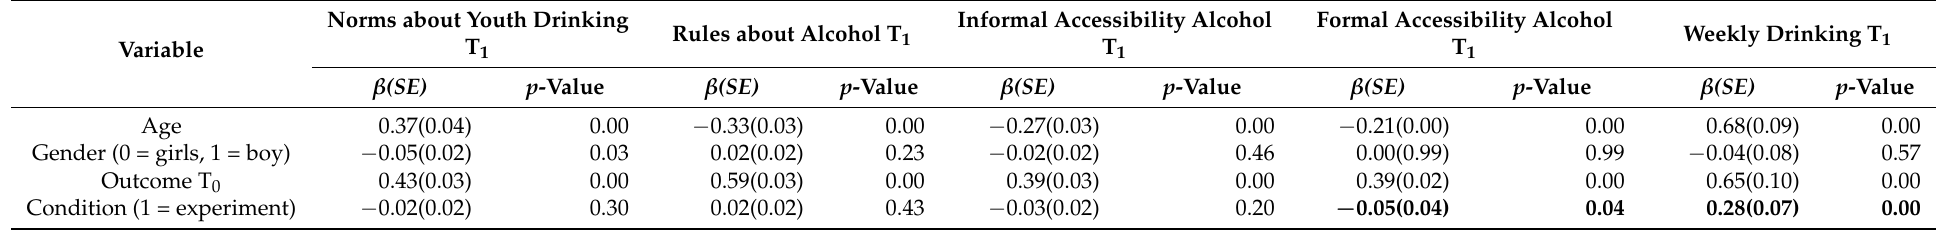
Table 2. Effects of Intervention Condition on Mechanisms (Norms about Youth, Rules about Alcohol, Accessibility of Alcohol) and Outcome (Weekly Drinking) at